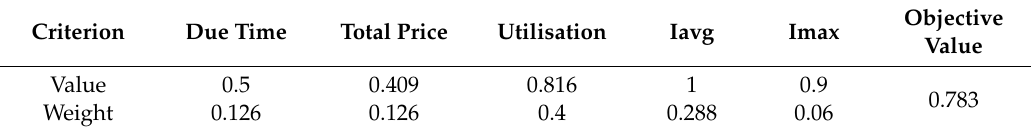
Table 3. The values of the criteria and the objective function for the indicative charging scenario.